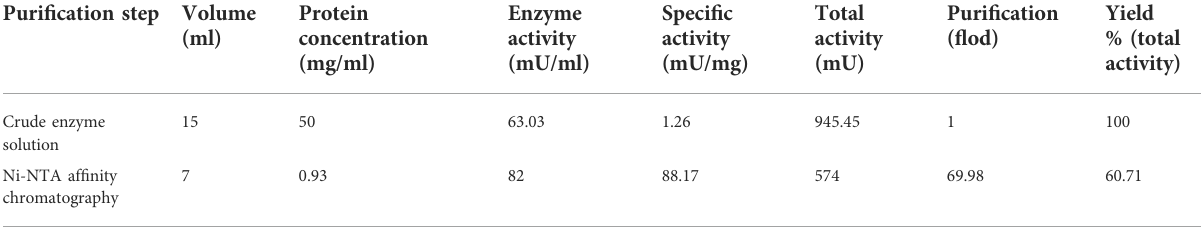
TABLE 2 Chitinase of Δ 30 Af ChiJ puri fi cation.